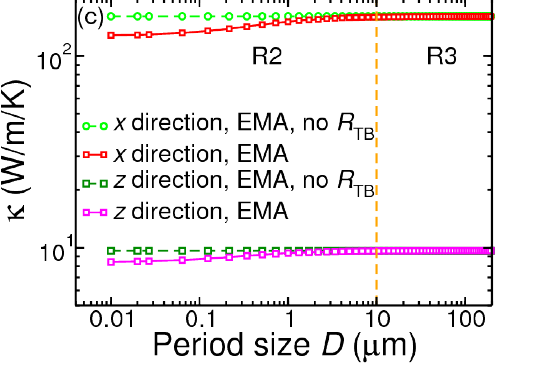
Figure 4. Period size dependence of cross-plane room-temperature thermal conductivity for: ( a ) Si( D /2)Ge( D /2) PSL; ( b ) NDSL (Ge insert of volume fraction f = 0.125 in Si matrix); and ( c ) TMD NDSL ( f = 0.125 of WS 2 inserted in MoS 2 ). Sample size L is 1 mm the Si/Ge composites in ( a , b ), and 100 mm for the MoS 2 /WS 2 composite in ( c ). Regions R1, R2 and R3 correspond to D << Λ , D ∼ Λ and D >> Λ , respectively, where D is repeat period and Λ represents phonon mean free